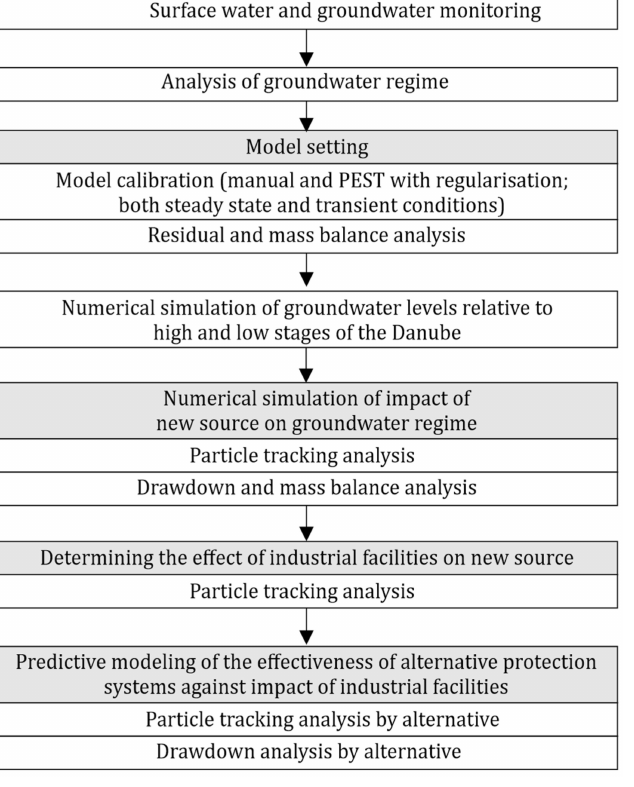
Figure 3. Investigations’